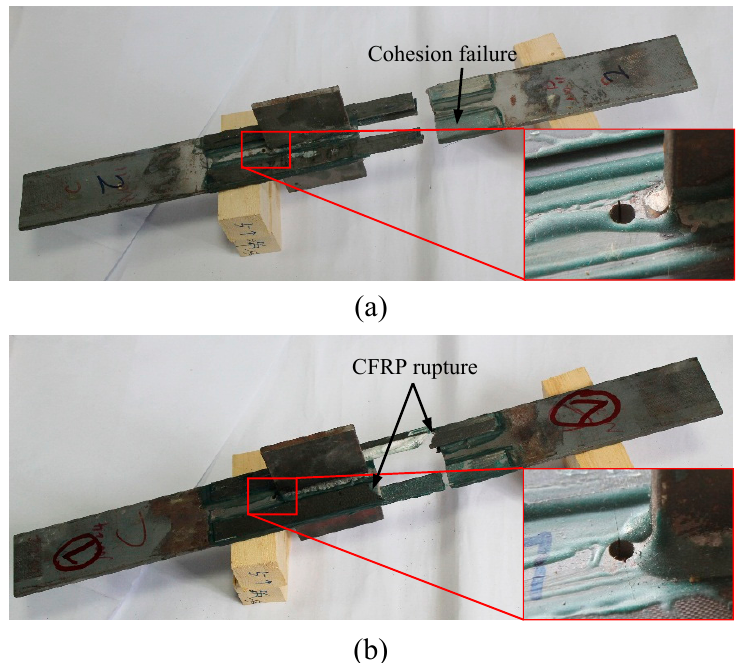
Figure 5. ( a ) Failed specimen ND-2 (normal modulus CFRP); ( b ) Failed specimen HD-2 (ultra-high modulus CFRP).